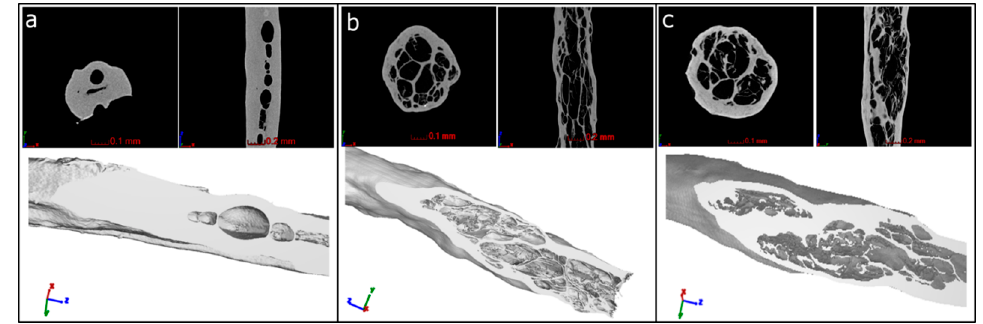
Figure 4. NanoCT images of a cross section and logitudinal section of a single strand of ( a ) PA; ( b ) AGG2; ( c ) AGG3. Bottom images: 3D reconstructed images of the CT scans with applied slice filter.